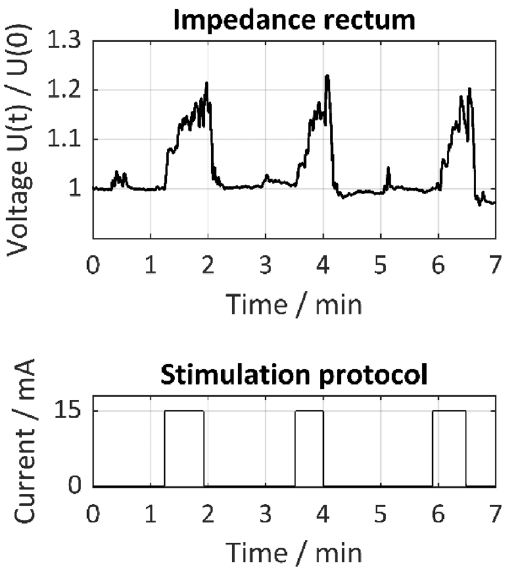
Figure 5. Normalized tissue impedance of the rectum U(t)/U(0) as a function of time during direct nerve stimulation with 15 mA, 1000 µs pulse width and 30 Hz on the paraproctium according to the depicted stimulation protocol. Impedance measurement was carried out with two needle electrodes (setup 1). Tissue impedance rises during direct nerve stimulation and decreases during relaxation and includes superimposed self-activity of the smooth muscle.